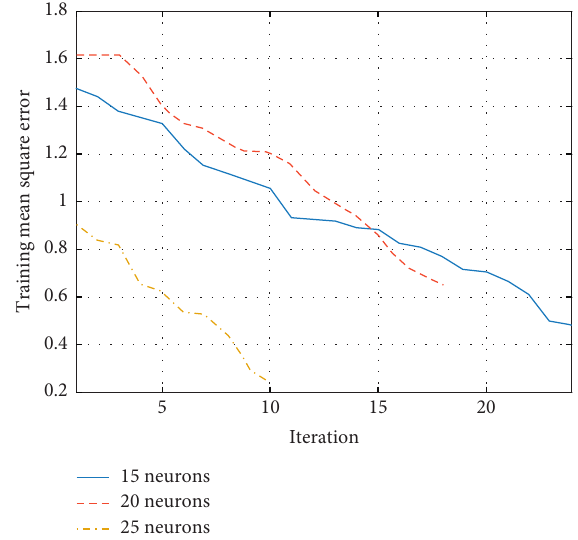
Figure 8: ANN training results for RRR arm with assuming 15, 20, and 25 neurons in the hidden layer.